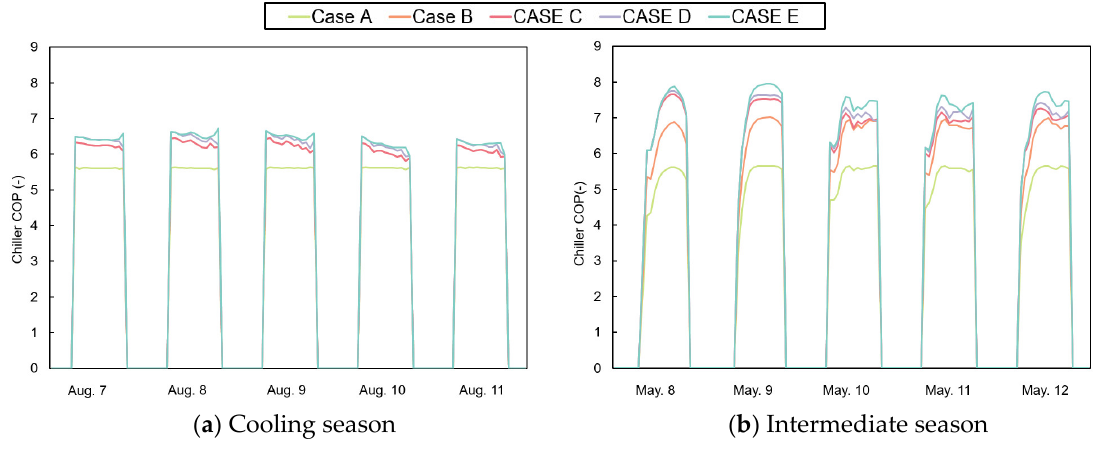
Figure 14. Weekly chiller COP for Case A–E.